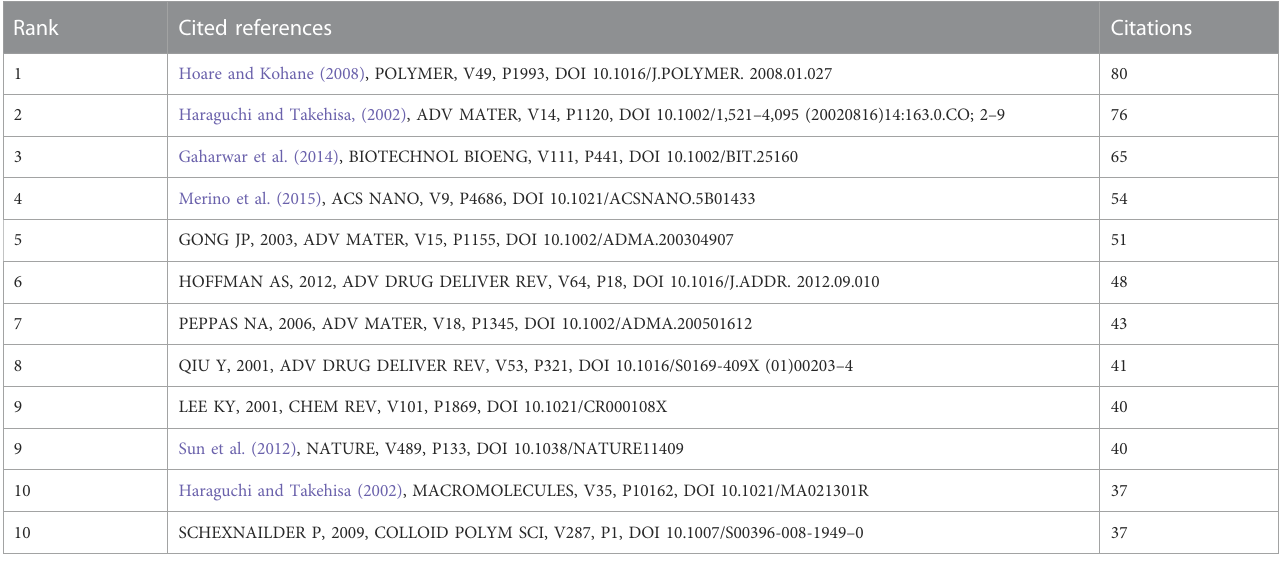
TABLE 3 Top 10 local cited references of publications related to the applications of NHs for drug delivery.